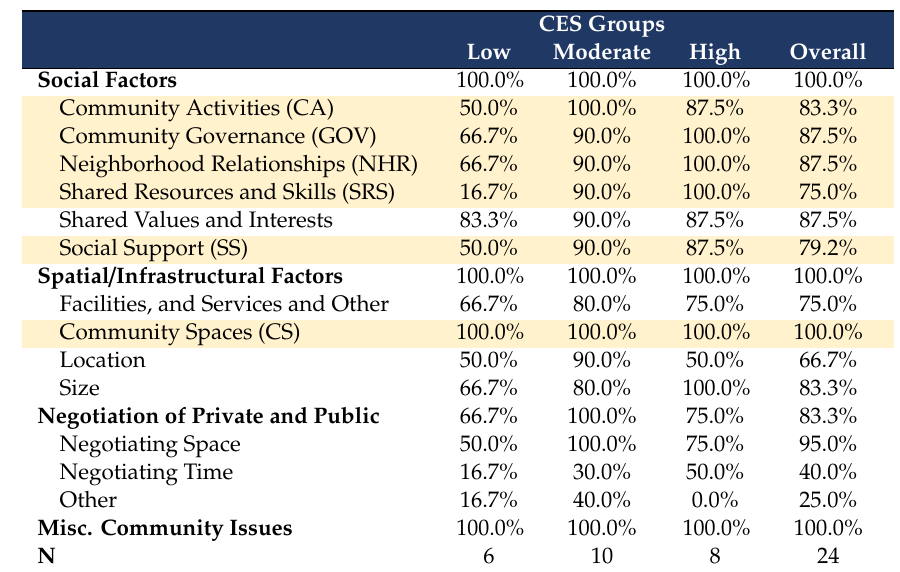
Table 1. Desired Community Characteristics Identified Via Interview Content Analysis [Broken Down by Overall Sample and Type of Community Engagement Style (CES) Group].